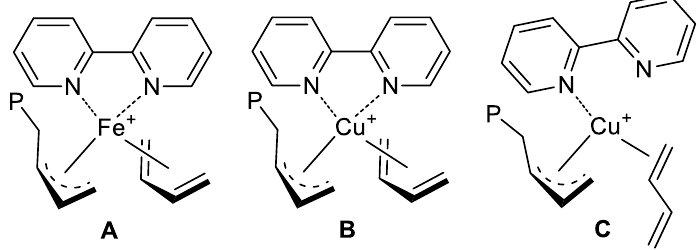
Figure 4. Possible catalytic center structures ( A - C ).